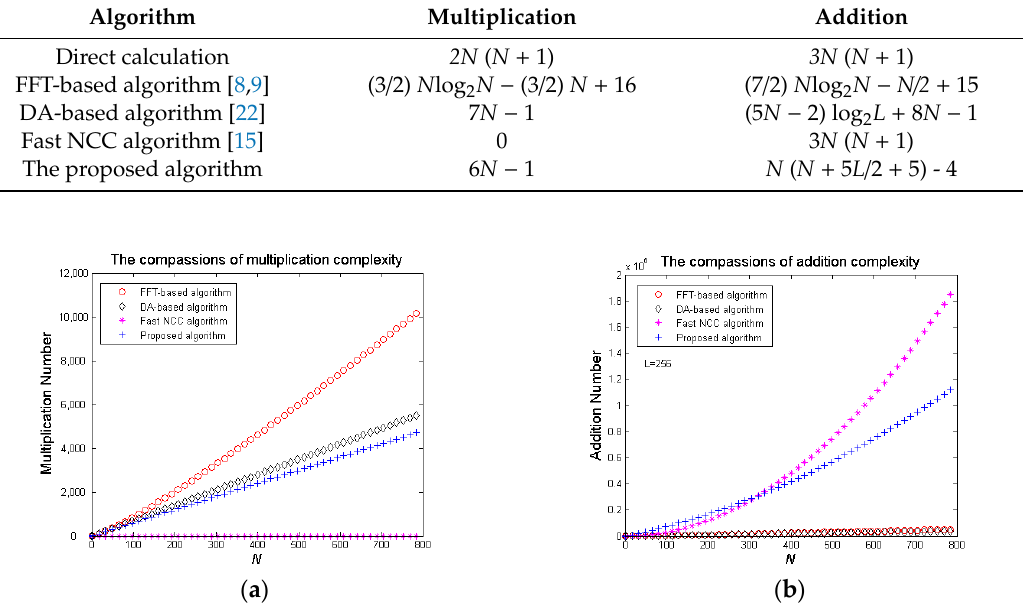
Figure 10. The four algorithm’s multiplication and addition number: ( a ) Multiplication ( b ) Addition.